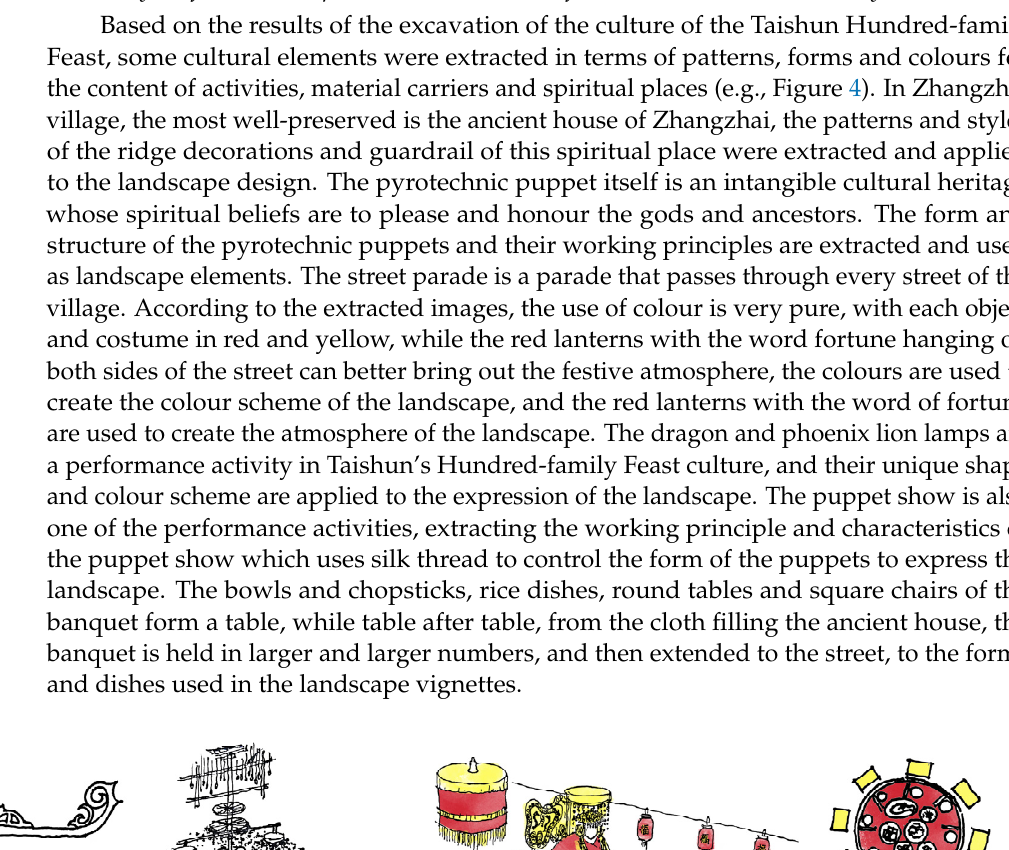
. Figure 5. Current situation of the centre in Sankui Town.